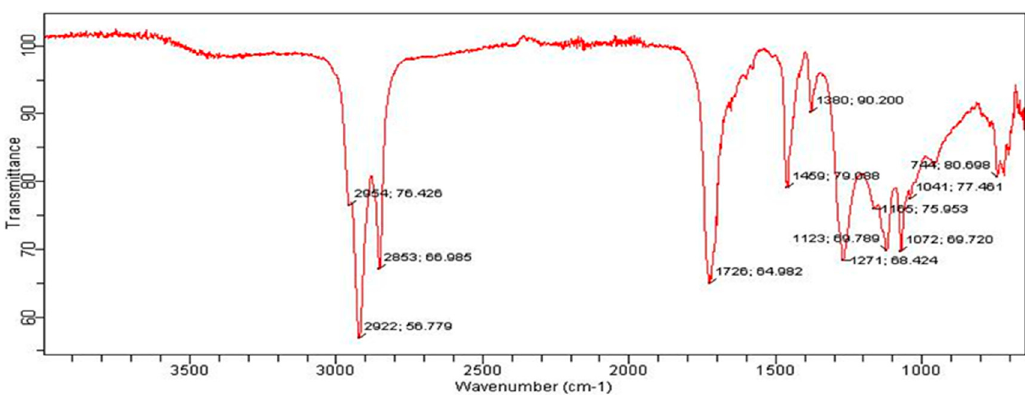
Figure 3. FTIR spectrum of CBC.